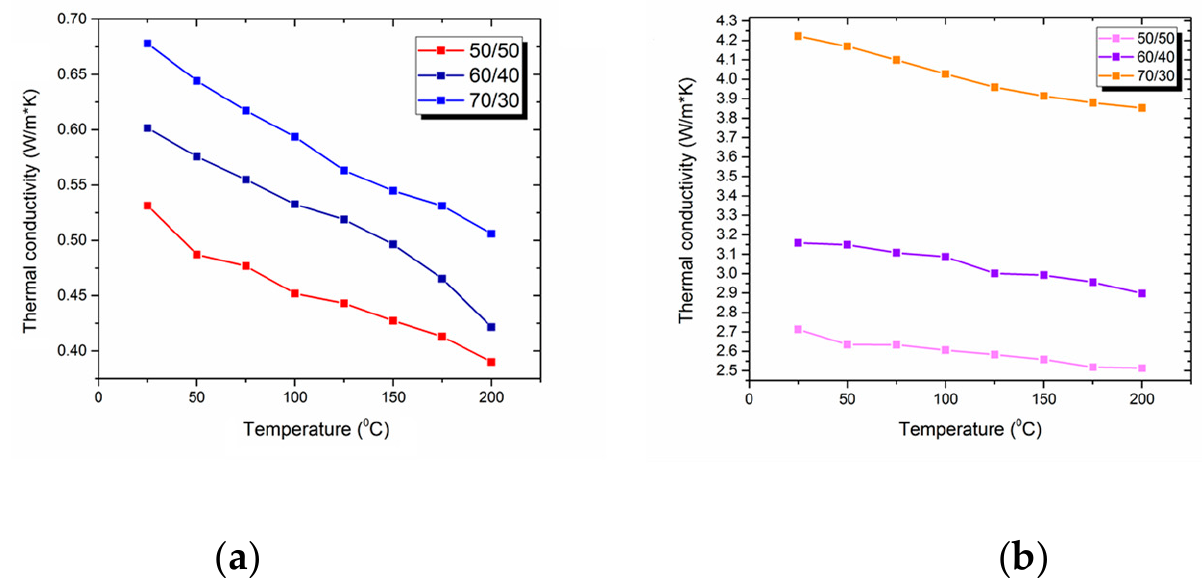
Figure 13. Results of the study of the thermal conductivity of the composites (with initial CF) ( a ) perpendicular to the reinforcing layers of CF and ( b ) along them.